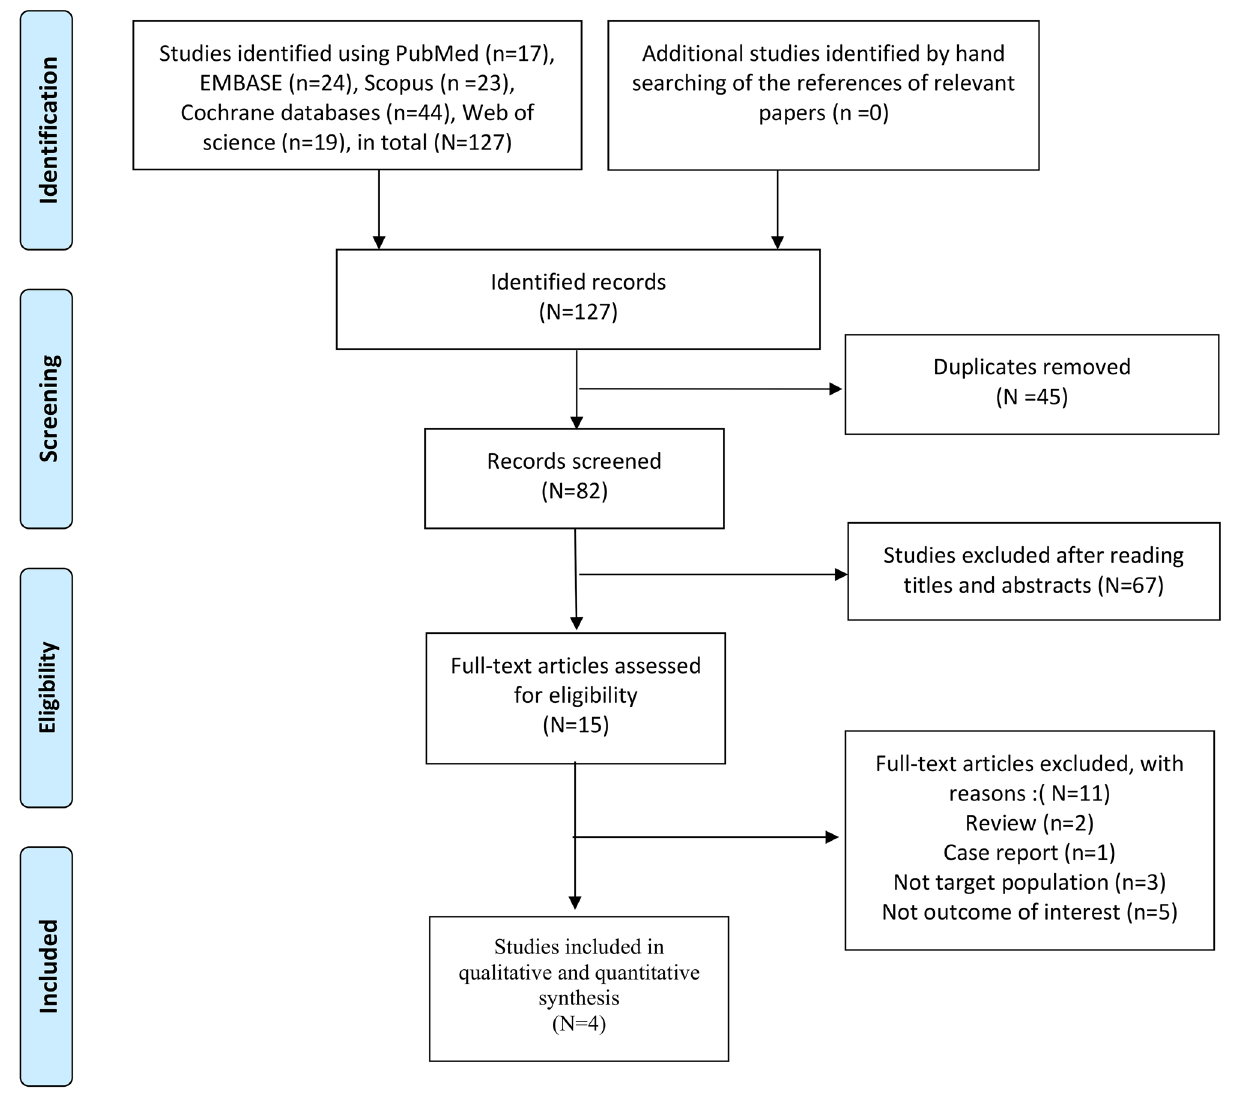
Figure 1. Flowchart of study selection for the current meta-analysis.